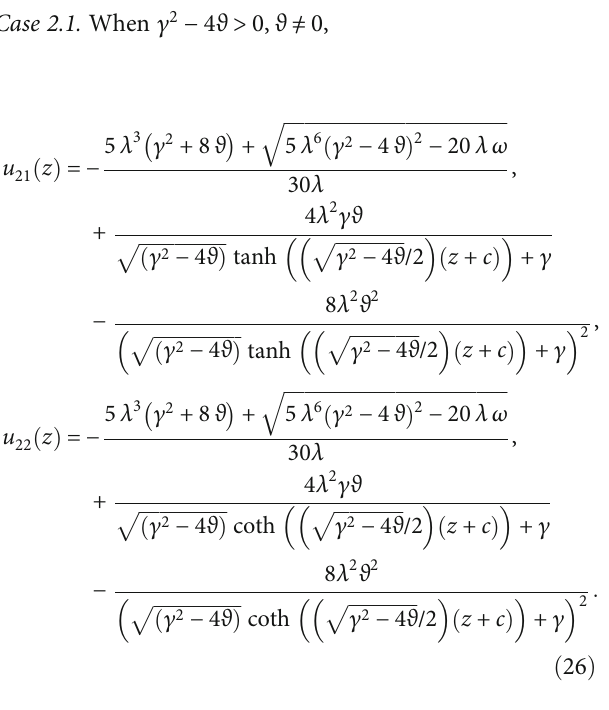
4 λ 2 γϑ p ffiffiffiffiffiffiffiffiffiffiffiffiffiffi 4 ϑ − γ 2 ffiffiffiffiffiffiffiffiffiffiffiffiffiffi 4 ϑ − γ 2